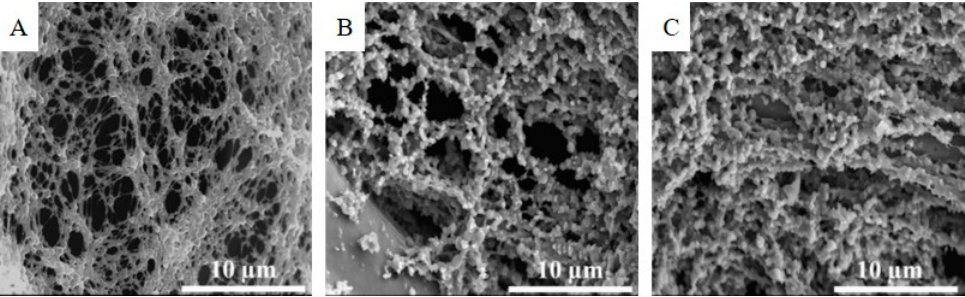
Figure 1. SEM pictures of the 3D structure of the glassy carbon foams, GCF ( A ), GCF-AC1 ( B ), and GCF-AC2 ( C ).